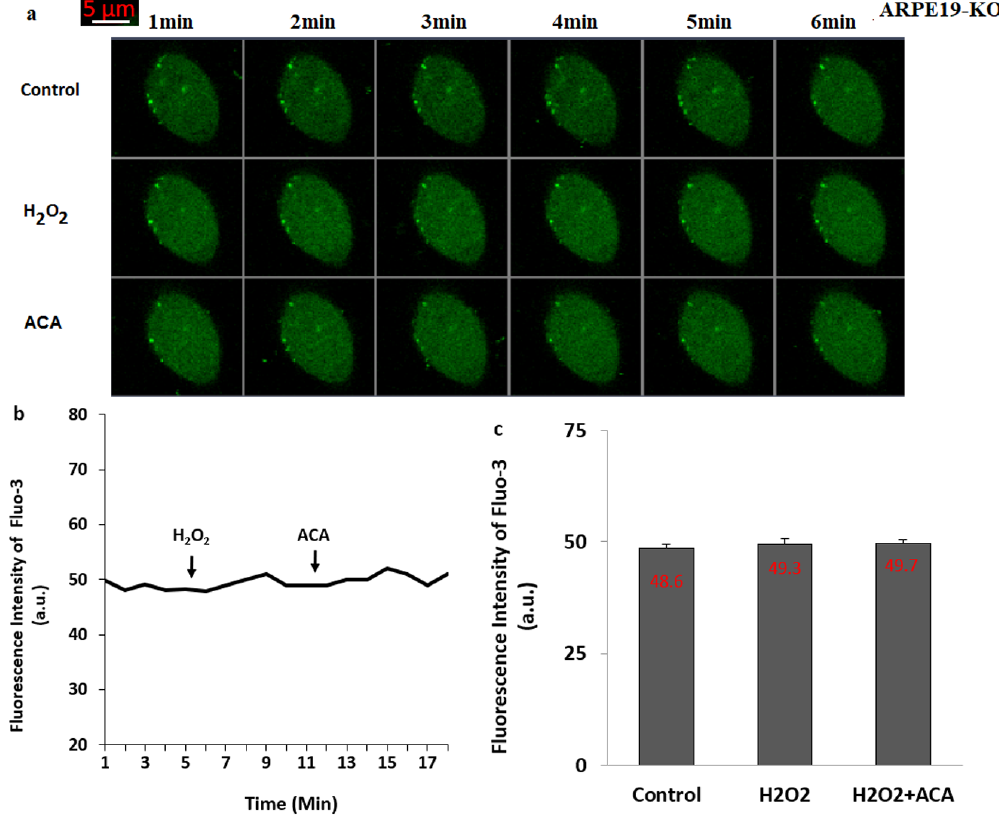
Figure 4. The stimulation of H 2 O 2 did not induce changes on the [Ca 2+ ] c and TRPM2 activation in the cells of ARPE19- KO . (Mean ± SD). After incubating the cells of ARPE19-KO with Fluo-3AM (1 µM for 60 min), the TRPM2 stimulator (H 2 O 2 and 1 mM) and blocker (ACA and 25 µM for 6 min) applied to the cells within three groups (control, H 2 O 2 and H 2 O 2 + ACA). The images of ARPE19-KO were captured in the LSM 800 with 40 × 1.3 oil objective. The scale bar was kept as 5 µm. The captured representative images (Figure 4a) and the mean Fluo-3AM intensity values (Figure 4b,c) in the groups of control (Cntr), H 2 O 2 and H 2 O 2 + ACA are shown in the Figure 4. One symbolic image from each group was selected from 25–30 cells of 6 independent investigations.